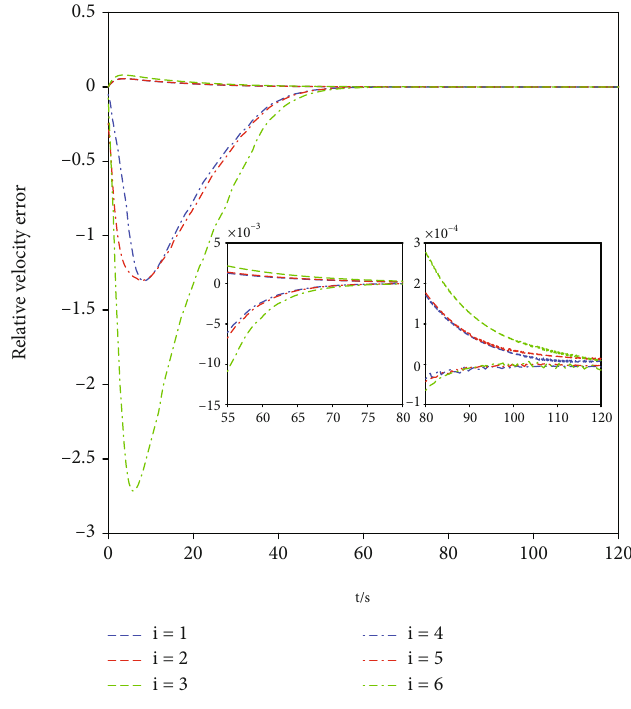
Figure 15: Relative velocity error curves.